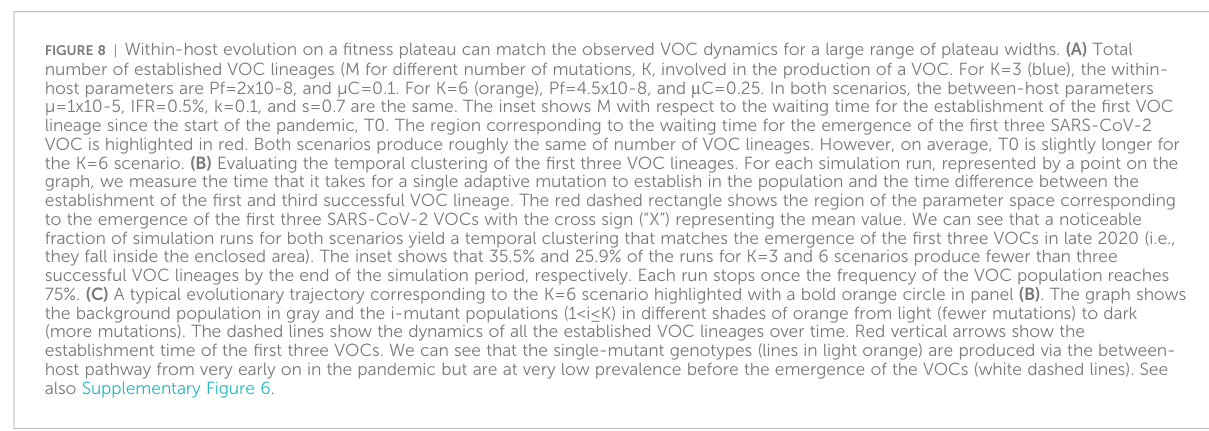
FIGURE 8 | Within-host evolution on a fi tness plateau can match the observed VOC dynamics for a large range of plateau widths. (A) Total number of established VOC lineages (M for different number of mutations, K, involved in the production of a VOC. For K=3 (blue), the within- host parameters are Pf=2x10-8, and µC=0.1. For K=6 (orange), Pf=4.5x10-8, and m C=0.25. In both scenarios, the between-host parameters µ=1x10-5, IFR=0.5%, k=0.1, and s=0.7 are the same. The inset shows M with respect to the waiting time for the establishment of the fi rst VOC lineage since the start of the pandemic, T0. The region corresponding to the waiting time for the emergence of the fi rst three SARS-CoV-2 VOC is highlighted in red. Both scenarios produce roughly the same of number of VOC lineages. However, on average, T0 is slightly longer for the K=6 scenario. (B) Evaluating the temporal clustering of the fi rst three VOC lineages. For each simulation run, represented by a point on the graph, we measure the time that it takes for a single adaptive mutation to establish in the population and the time difference between the establishment of the fi rst and third successful VOC lineage. The red dashed rectangle shows the region of the parameter space corresponding to the emergence of the fi rst three SARS-CoV-2 VOCs with the cross sign ( “ X ” ) representing the mean value. We can see that a noticeable fraction of simulation runs for both scenarios yield a temporal clustering that matches the emergence of the fi rst three VOCs in late 2020 (i.e., they fall inside the enclosed area). The inset shows that 35.5% and 25.9% of the runs for K=3 and 6 scenarios produce fewer than three successful VOC lineages by the end of the simulation period, respectively. Each run stops once the frequency of the VOC population reaches 75%. (C) A typical evolutionary trajectory corresponding to the K=6 scenario highlighted with a bold orange circle in panel (B) . The graph shows the background population in gray and the i-mutant populations (1<i ≤ K) in different shades of orange from light (fewer mutations) to dark (more mutations). The dashed lines show the dynamics of all the established VOC lineages over time. Red vertical arrows show the establishment time of the fi rst three VOCs. We can see that the single-mutant genotypes (lines in light orange) are produced via the between- host pathway from very early on in the pandemic but are at very low prevalence before the emergence of the VOCs (white dashed lines). See also Supplementary Figure